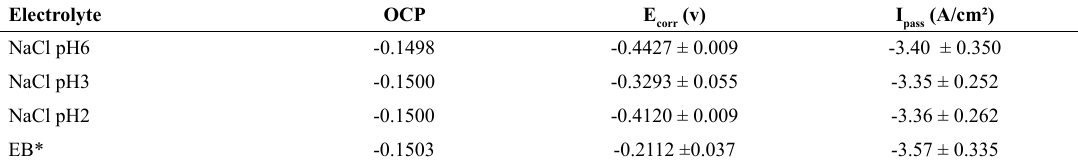
*EB – Mouthwash solution